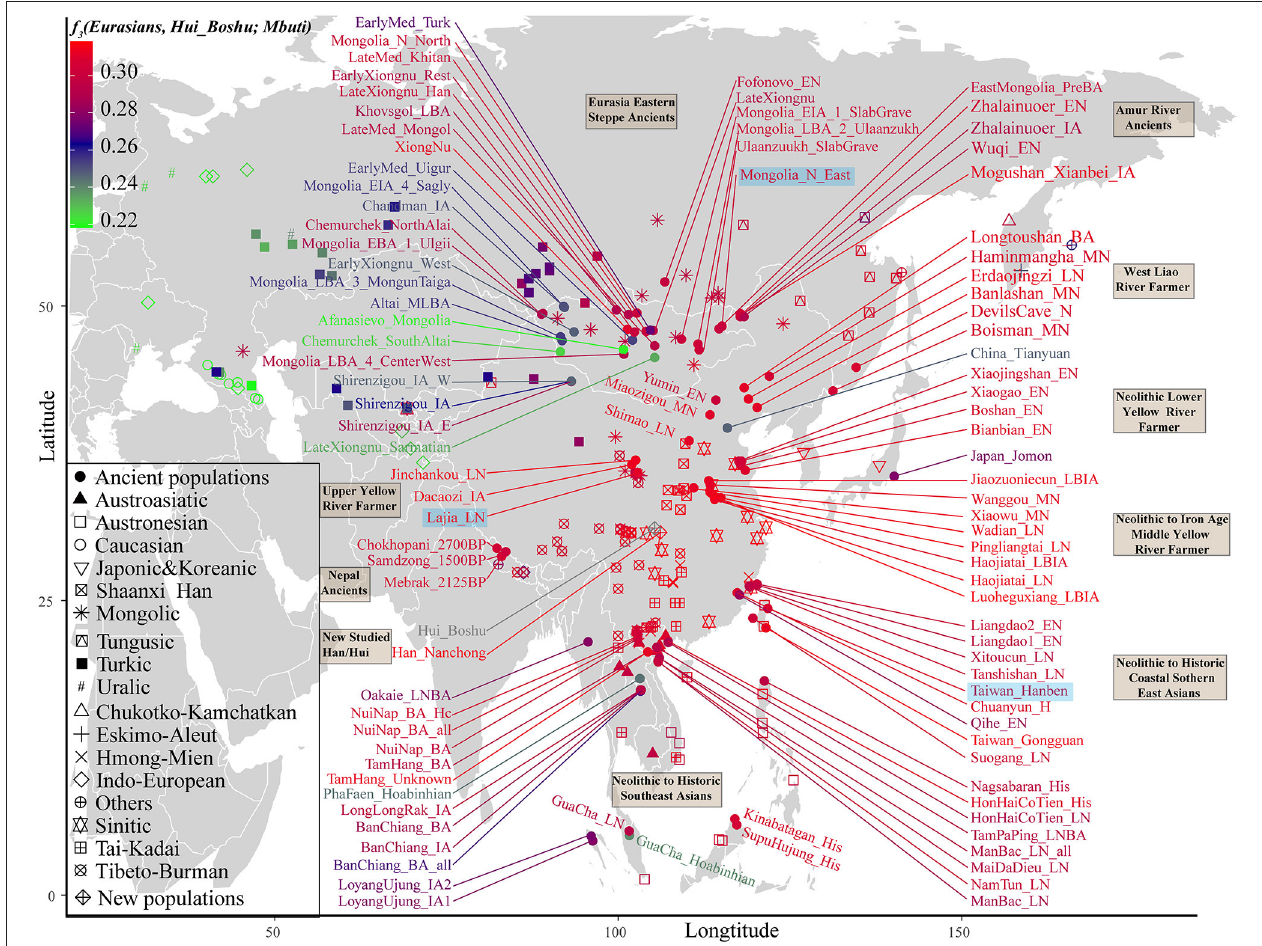
FIGURE 2 | Heatmap showing the genetic affinity between Boshu Hui and modern/ancient Eurasians estimated by f 3 -statistic in the form f 3 (Eurasian, Hui_Boshu, Mbuti) . The red color denotes higher genetic affinity, suggesting their genetic affinity to Hui people. The green color denotes a smaller f 3 -value, suggesting their distant relationship with the Hui people. Here, the main ancient populations were used in the qpGraph -based admixture modeling marked with the light blue background. LBA, Late Bronze Age; IA, Iron Age; MLBA, Middle and Late Bronze Age; LN, Late Neolithic; EN, Early Neolithic; MN, Middle Neolithic; LBIA, Late Bronze Age and Iron